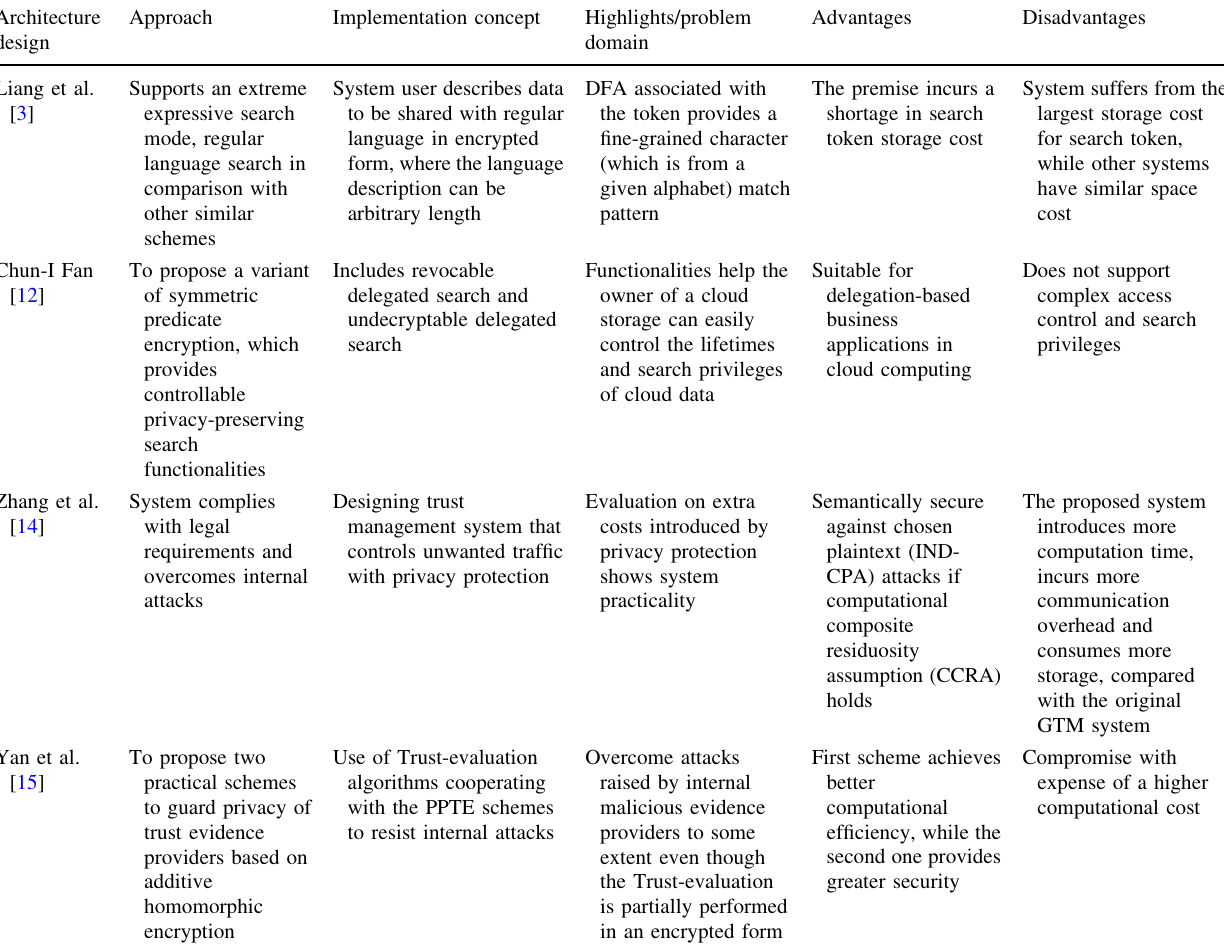
Table 2 Comparison of predicate-based evaluation approaches Architecture